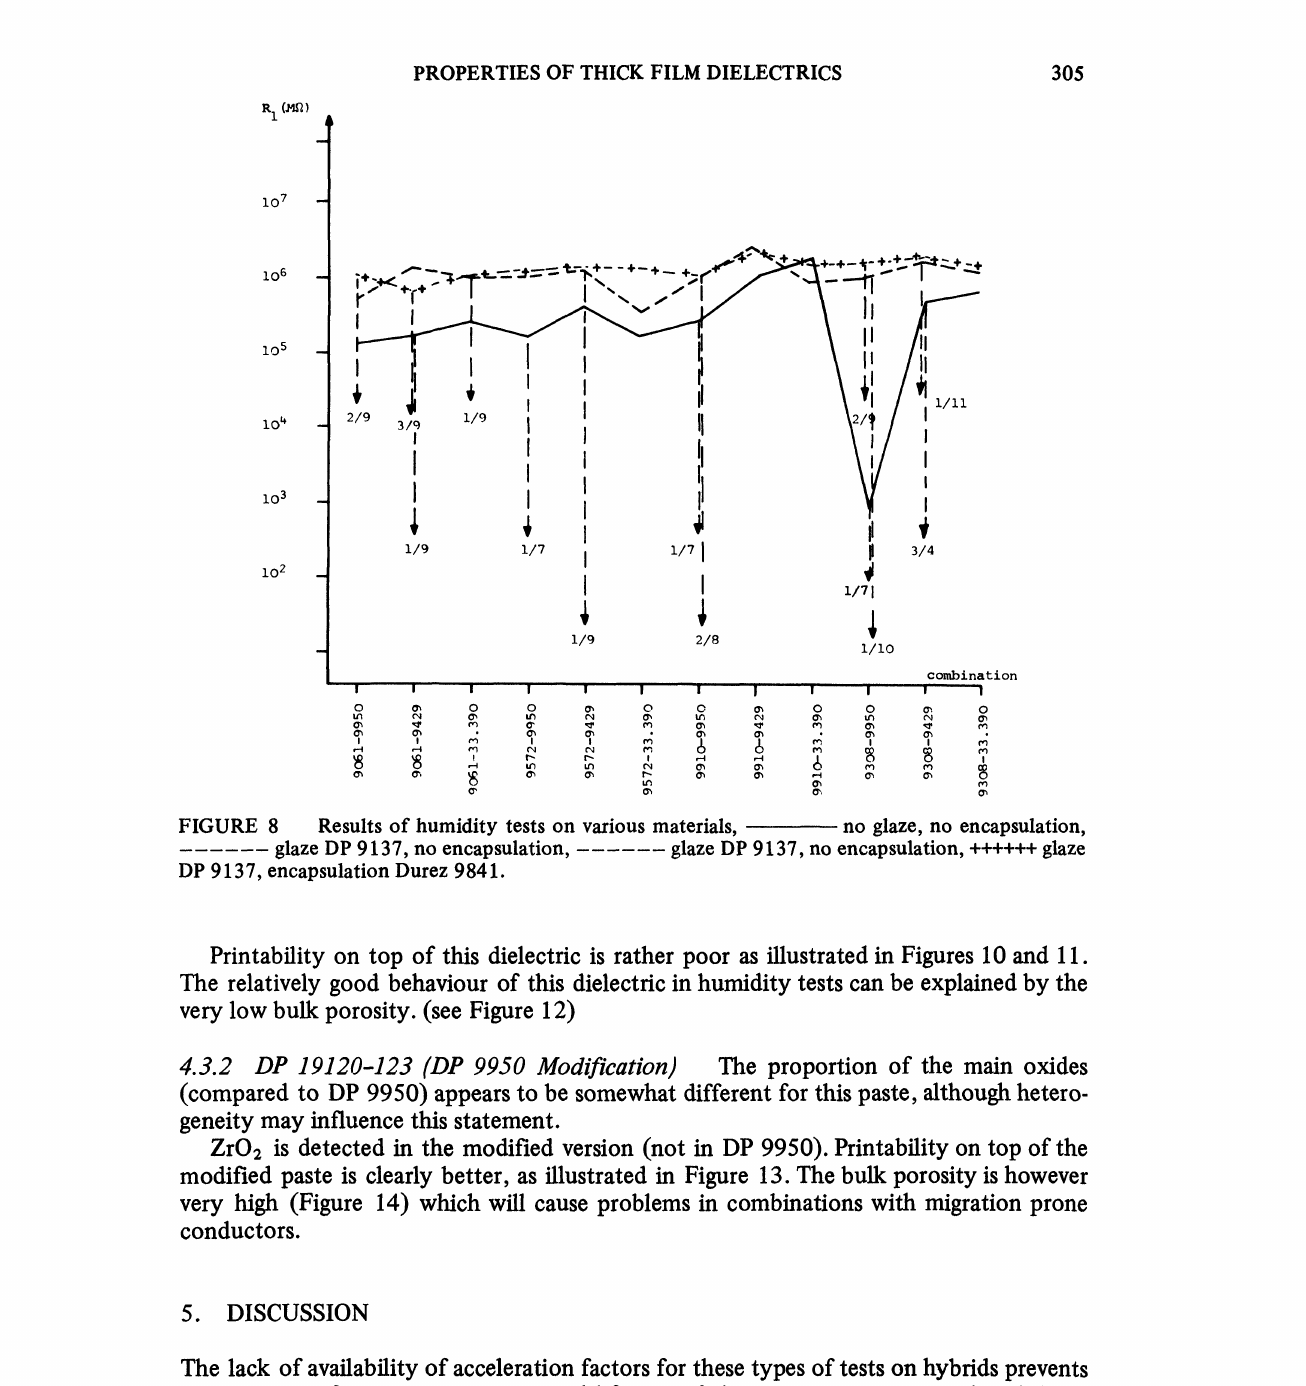
no glaze, no encapsulation, glaze DP 9137, no encapsulation, ++++++